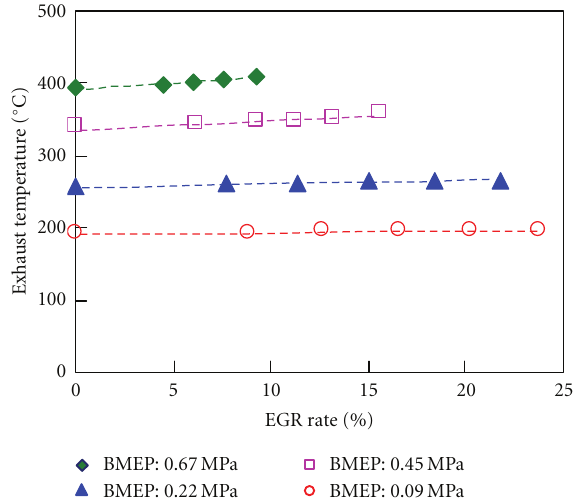
Figure 5: The exhaust temperature of di ff erent modes.